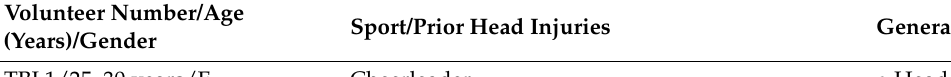
Table 1. mTBI patients, injuries and